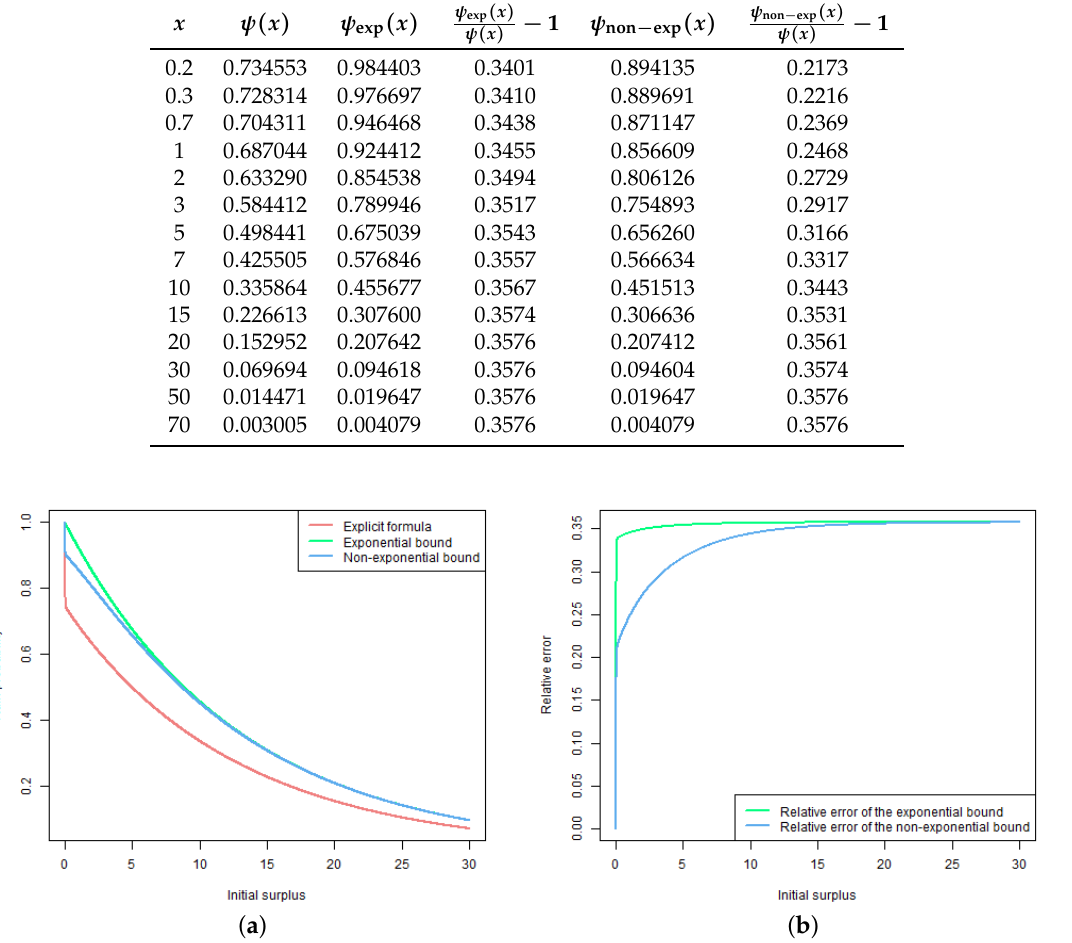
Figure 4. Comparison of the results for the model considered in Example 4: ( a ) Ruin probability given by the explicit formula as well as the exponential and non-exponential bounds for it. ( b ) Relative errors of the exponential and non-exponential